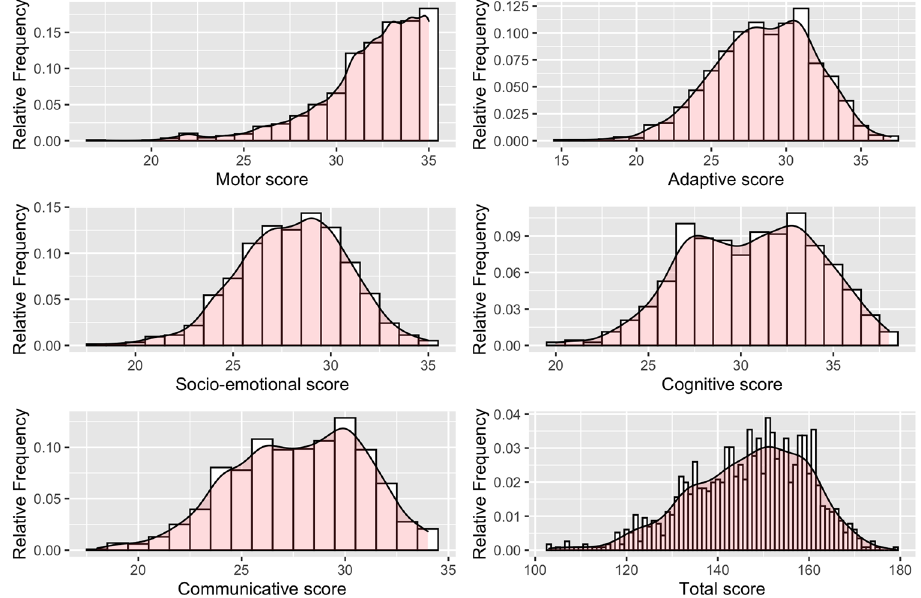
Figure 1. Distribution of the developmental score by domain of interest.